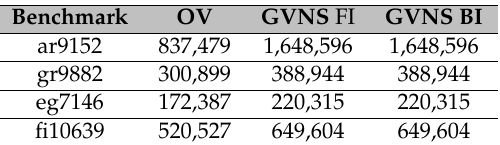
Table 6. GVNS on National